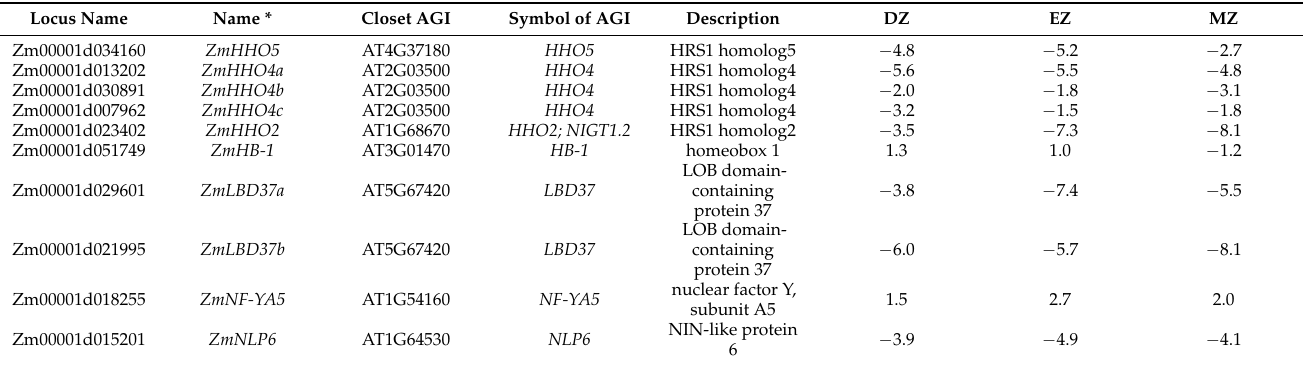
Table 2. Transcription factors identified in the common